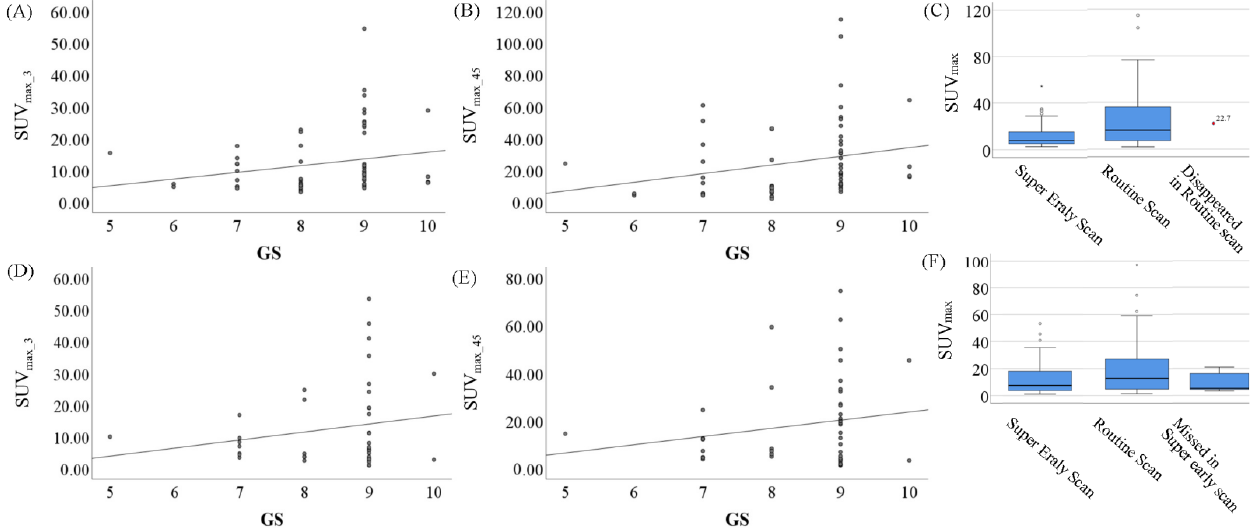
Figure 2. Correlation between Gleason scores and SUV max , including the primary lesion at 3 min ( A ) and 45 min ( B ) P.I., and the corresponding box–whisker plots ( C ) of SUV max acquired at super early scan and routine scan, as well as the disappeared lesion in routine scan. The same results of the metastatic lesions are exhibited in ( D – F ) (the missed lesion in super early scan).